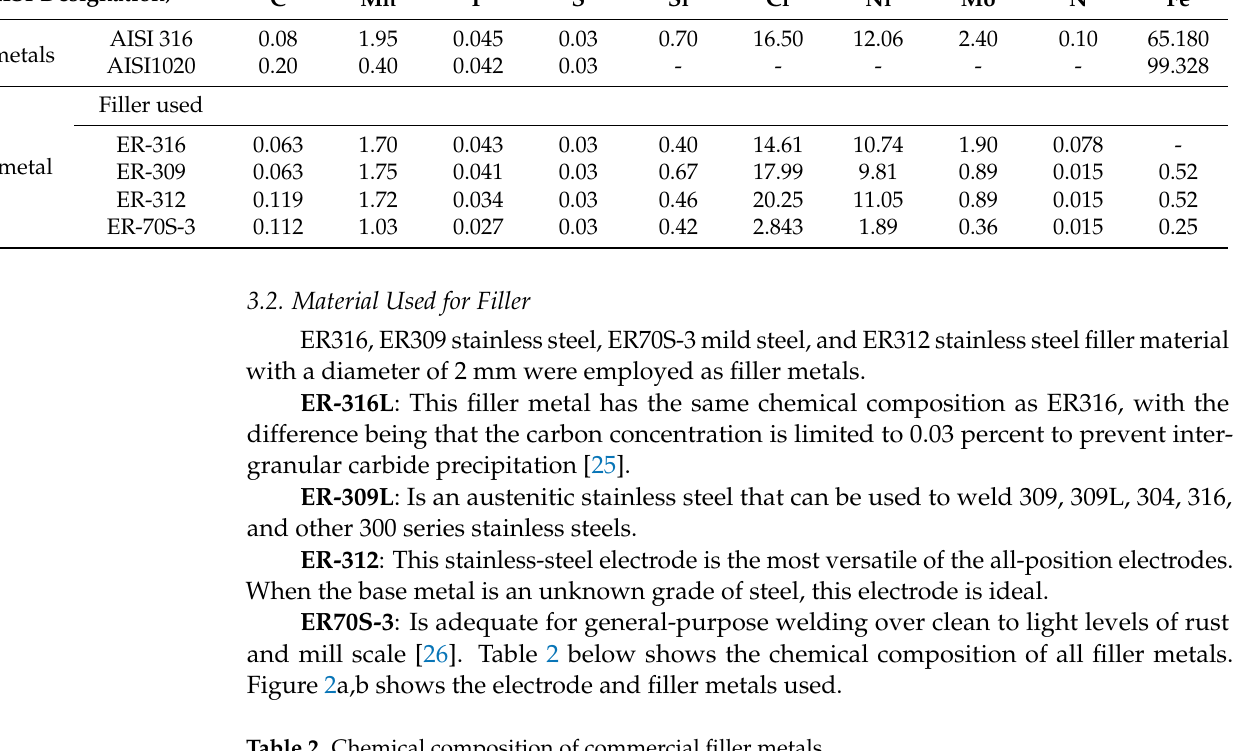
Table 2. Chemical composition of commercial filler metals.